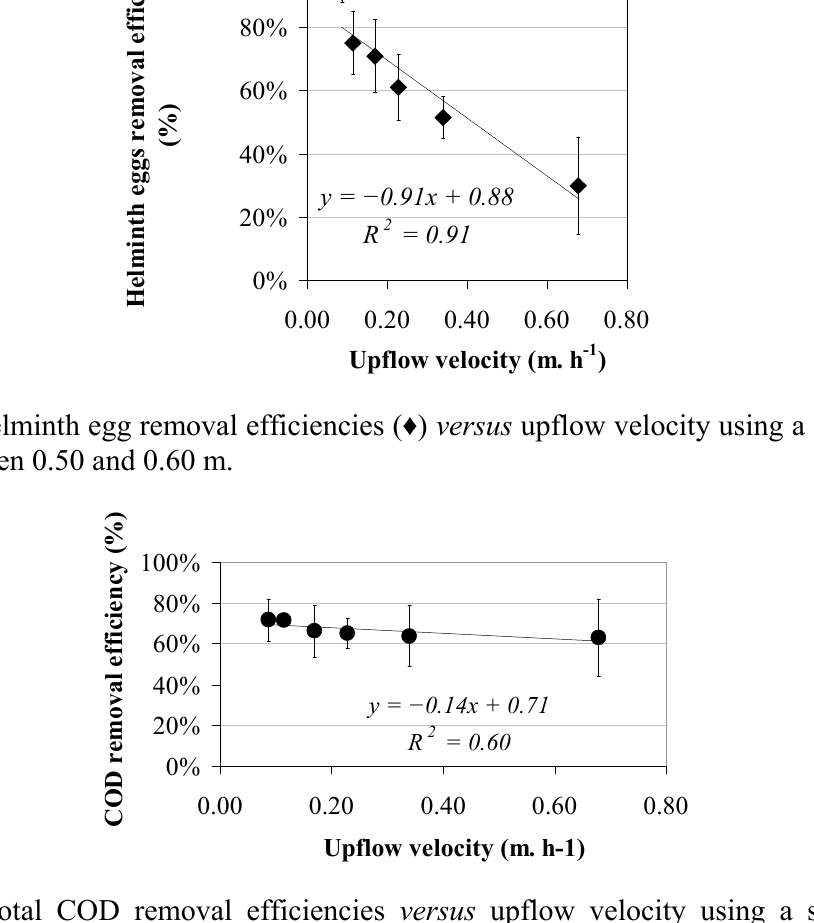
Figure 5. Total COD removal efficiencies versus upflow velocity using a sludge bed height between 0.50 and 0.60